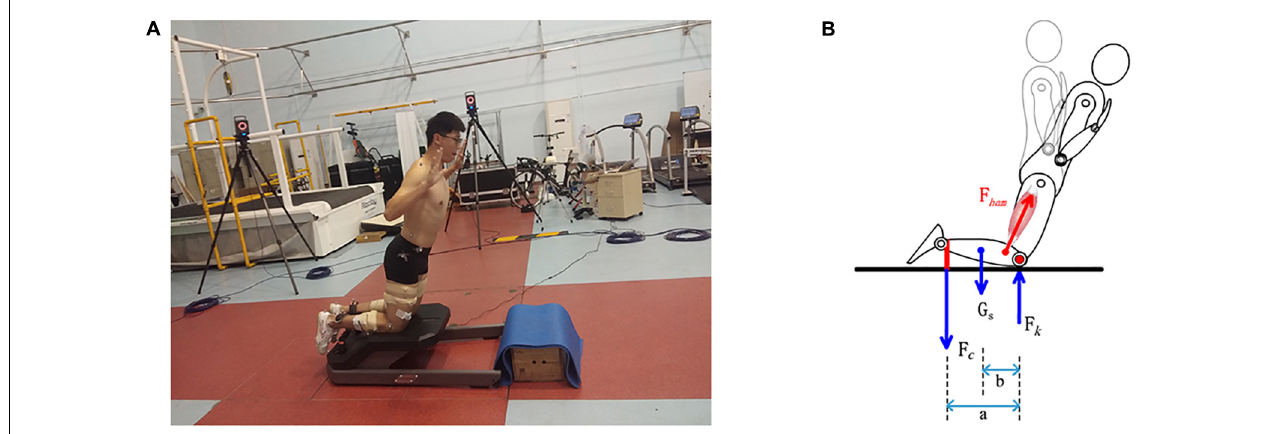
FIGURE 1 | (A) Marker set up and the instrumented device (Nordbord) for assessing Nordic hamstring exercise. (B) Free body diagram for the shank during Nordic hamstring exercise.